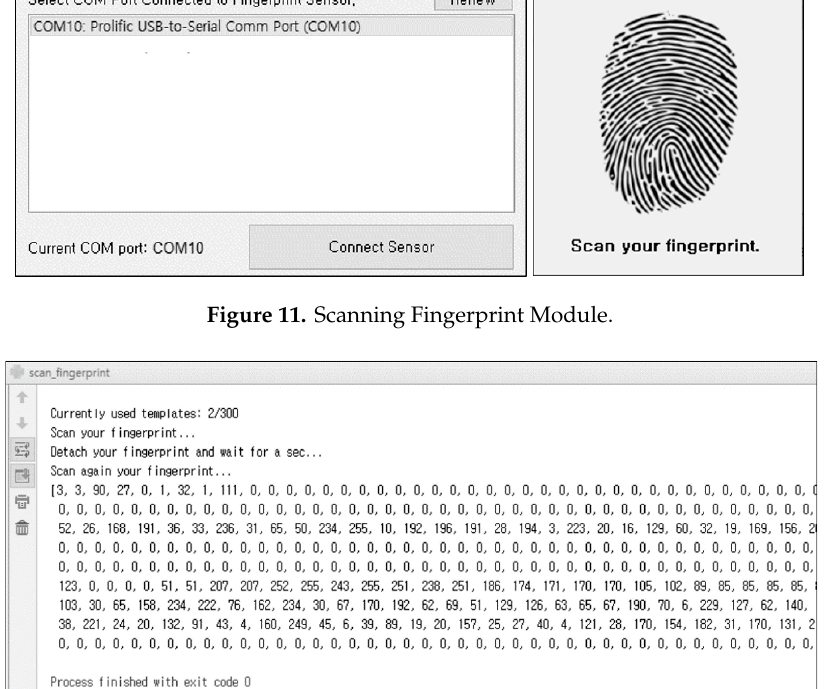
Figure 11. Scanning Fingerprint Module.